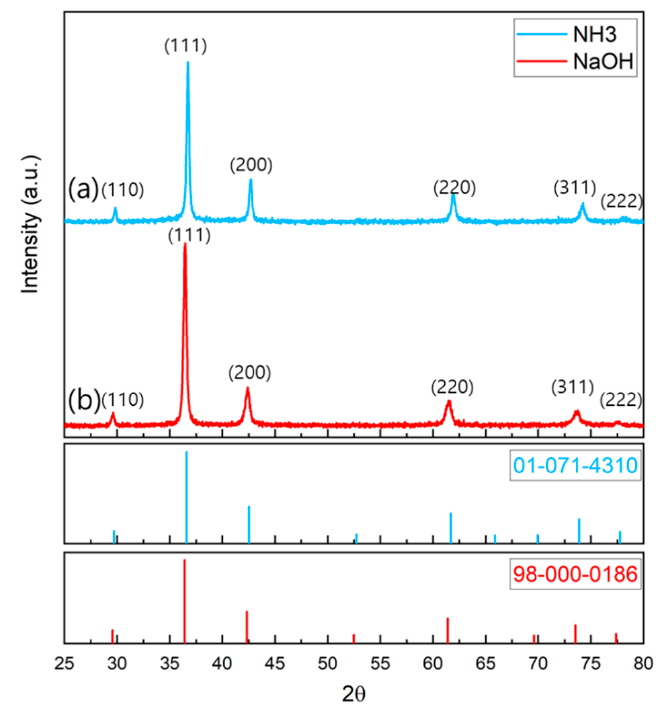
Figure 1. XRD patterns of Cu 2 O NPs ( a ) with NH 3 (ICDD PDF#01-071-4310) and ( b ) without NH 3 (ICDD PDF#98-000-0186).